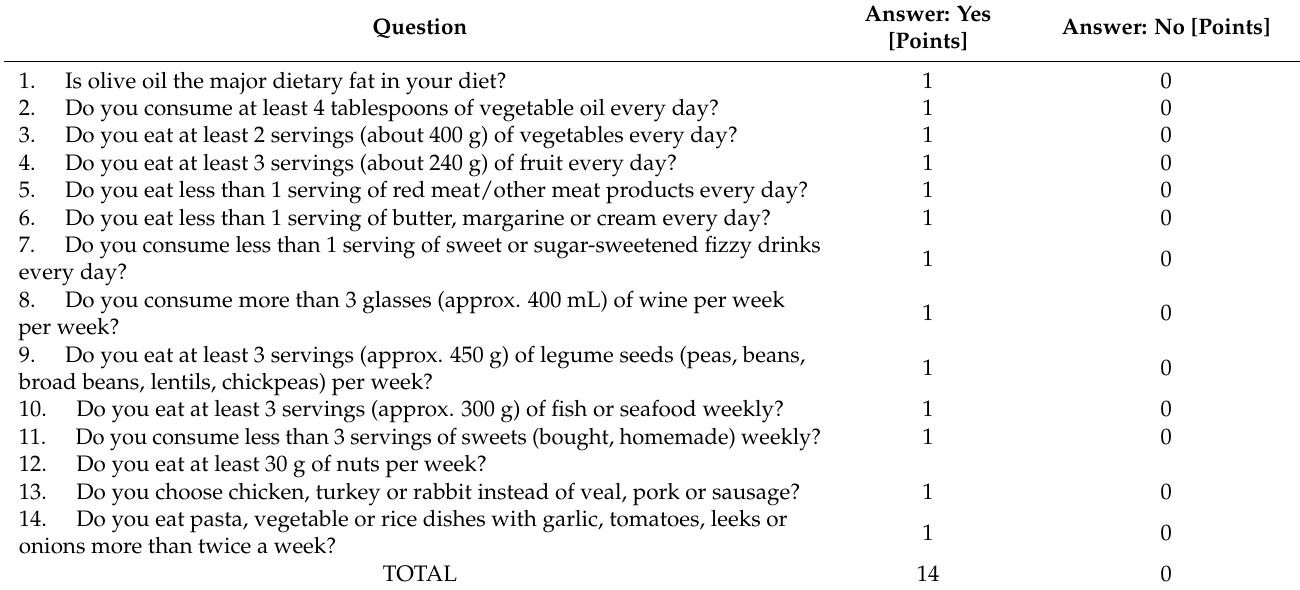
Table 1. Interpretation of Mediterranean Diet Adherence